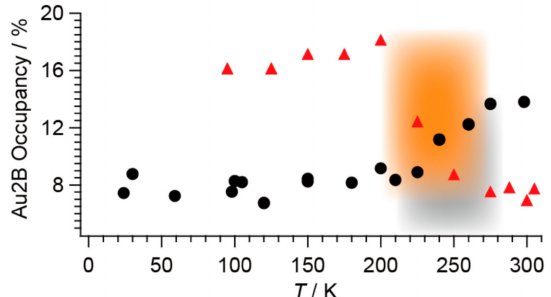
Figure 14. Temperature-dependence of the Au2B site occupancy (Occ (%)) under dark (black circles) and UV-irradiated (red triangles) conditions. There are two of crystallographically independent Au sites in BPY[Au(dmit) 2 ] 2 , Au1 and Au2. Together, Au2A (P) and Au2B (NP) form Au(dmit) 2 anions that face the BPY cations. The remaining Au atoms (Au1) are not disordered. Grey and orange square shades show the transition temperature ranges under dark and UV irradiated conditions, respectively. Reproduced from Ref. [13] and modified with permission from the Royal Society of Chemistry.